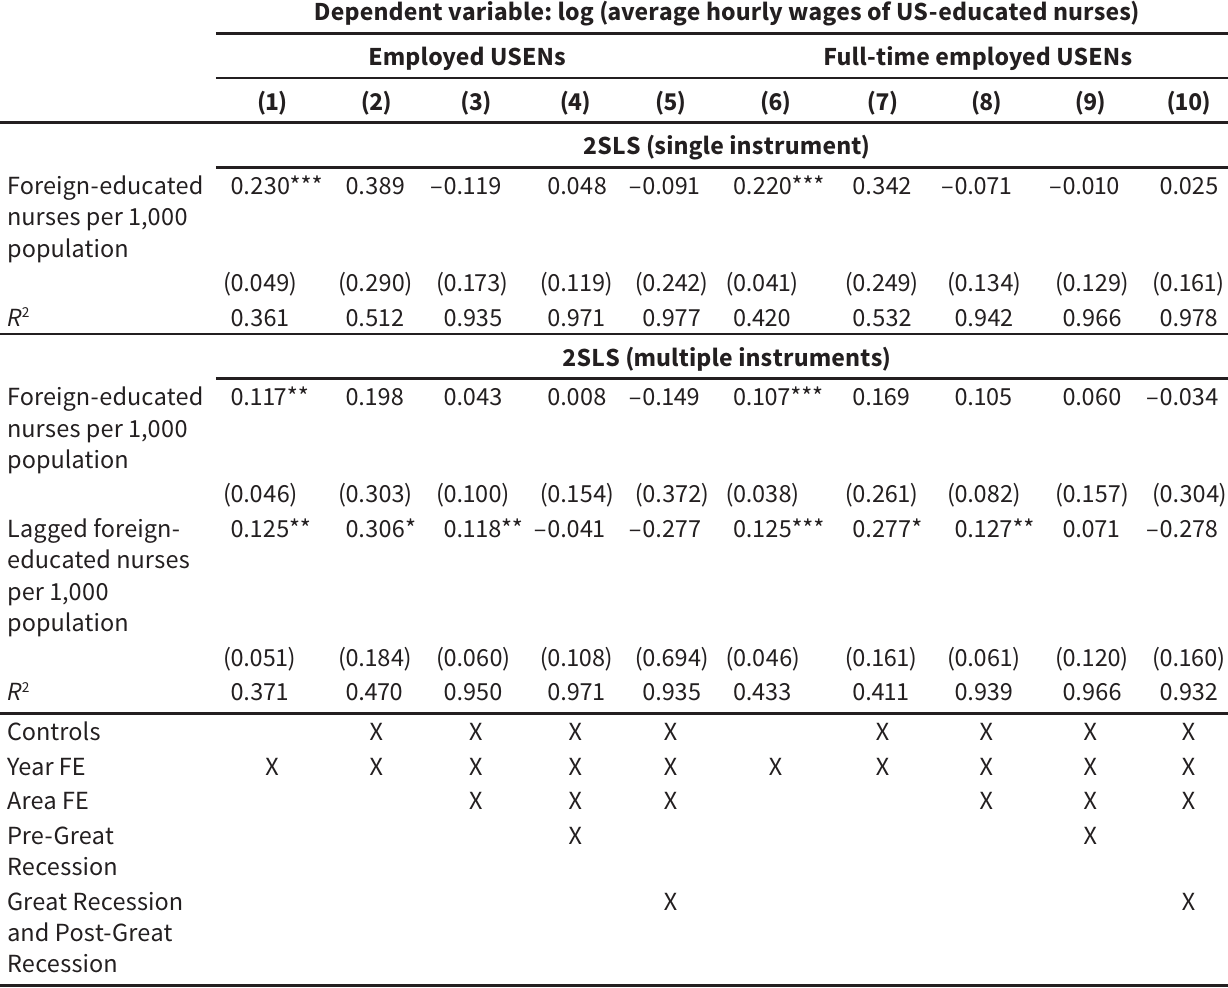
Wage effects of foreign-educated RNs on US-educated RNs, 2000–2015 Dependent variable: log (average hourly wages of US-educated